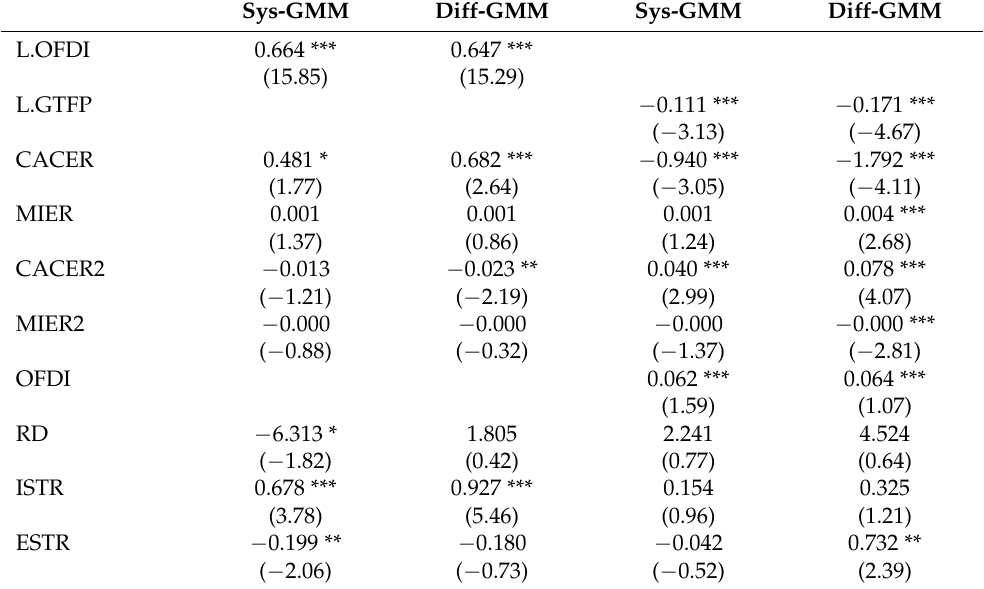
Table 9. Robust test results.